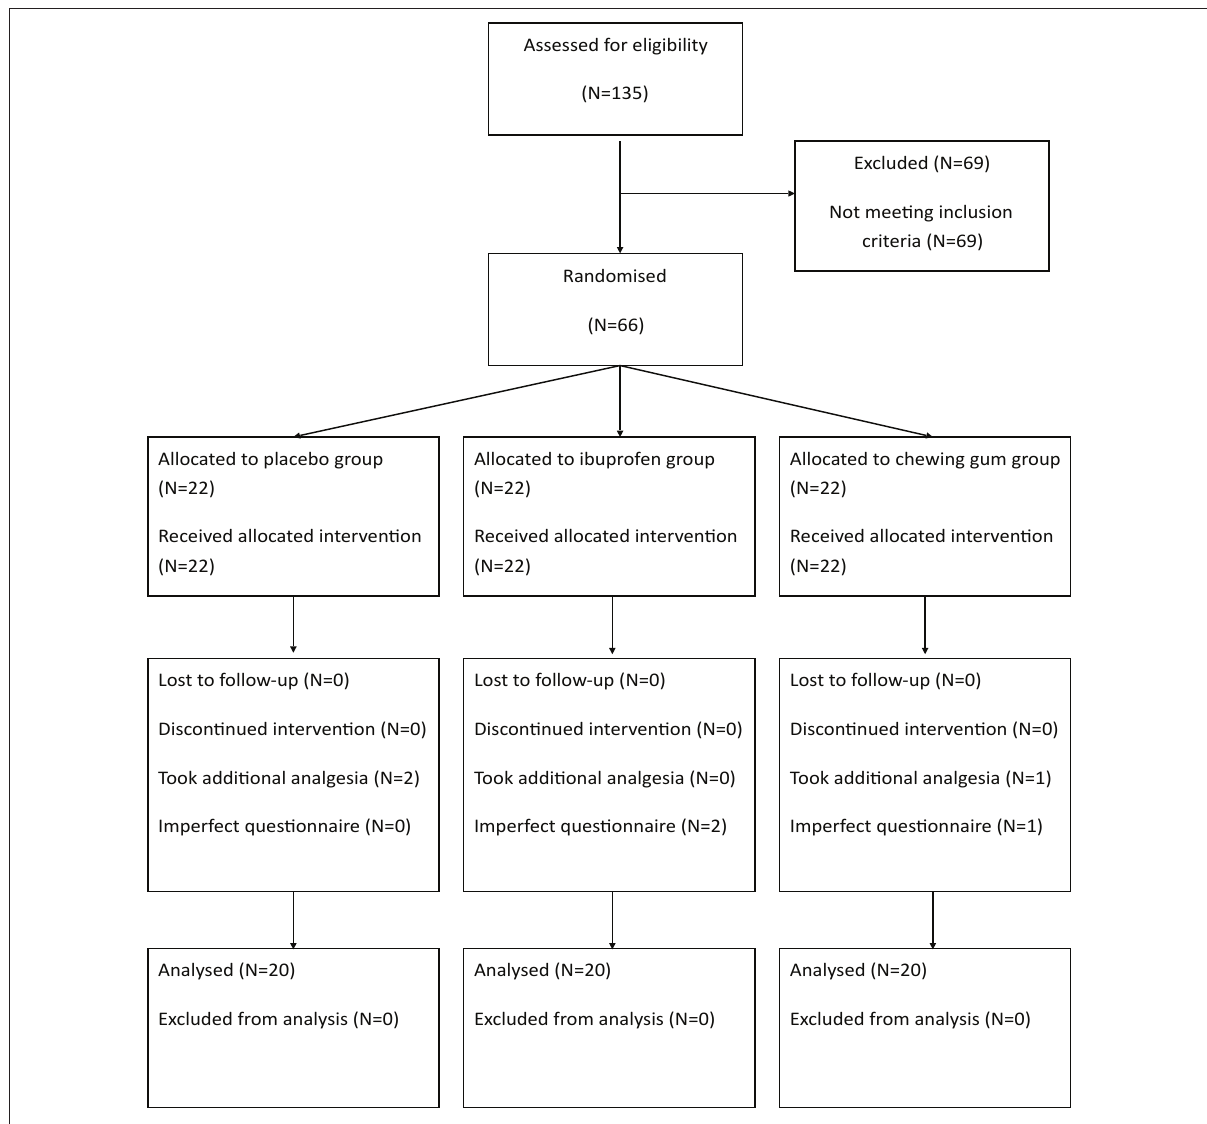
Figure 1. CONSORT diagram showing the flow of participants through each stage of the